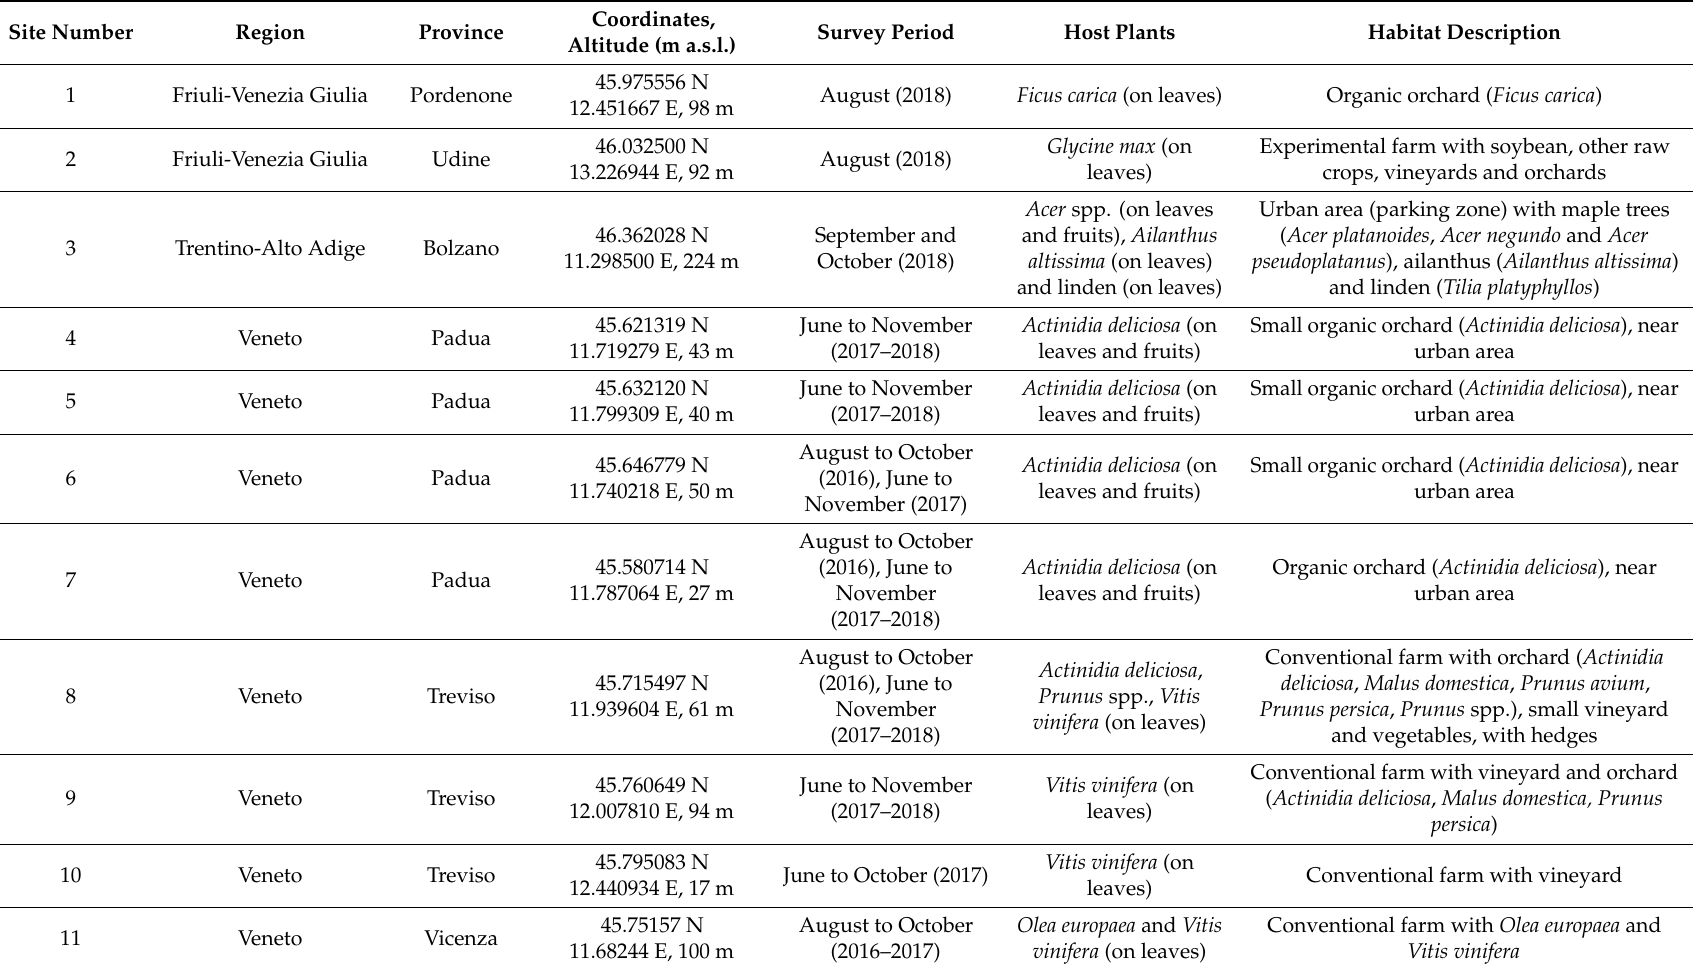
Table 1. Collection sites of Halyomorpha halys egg masses in Italy, listed in alphabetic order by region and